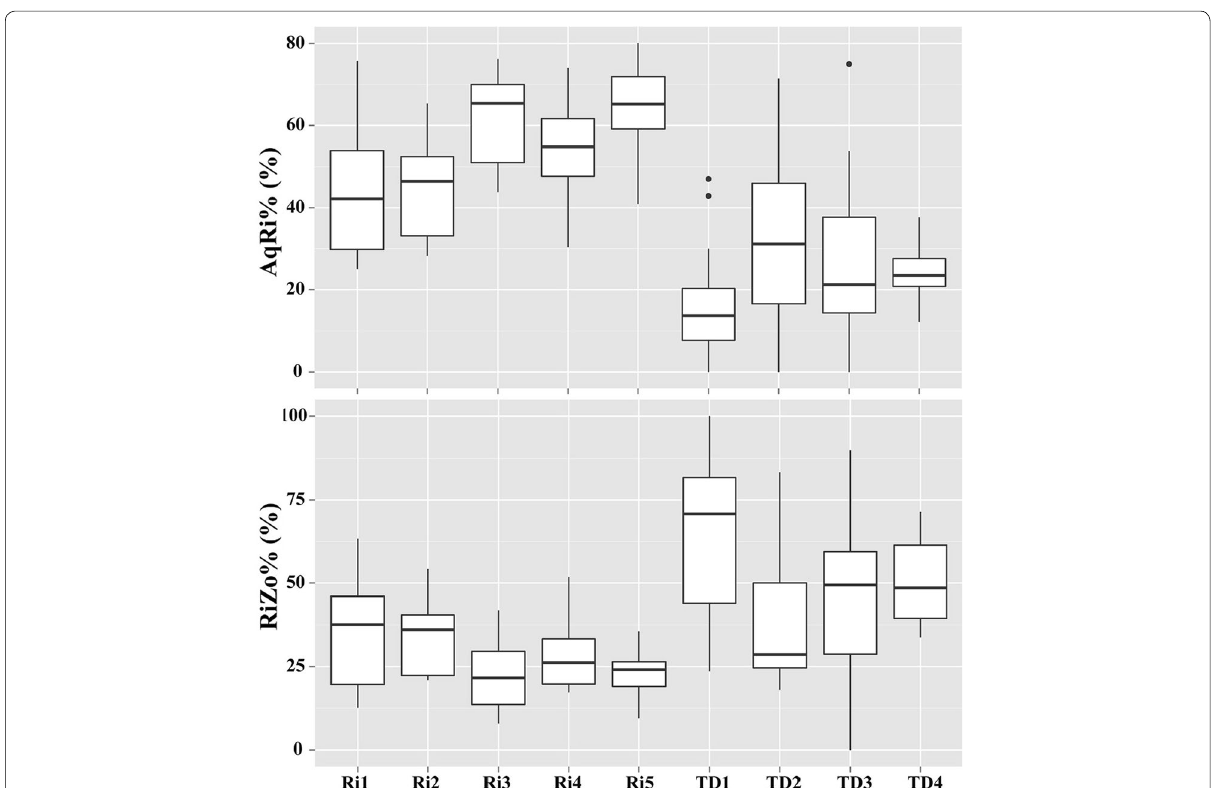
Fig. 4 Box plots of AqRi% and RiZo% at different sampling sites. Boxes show interquartile ranges (25th and 75th%), middle lines are medians, whisk‑ ers are non‑outlier ranges beyond the boxes, and dots are outliers. AqRi, Aquatic/Riparian transition zone; RiZo, Riparian